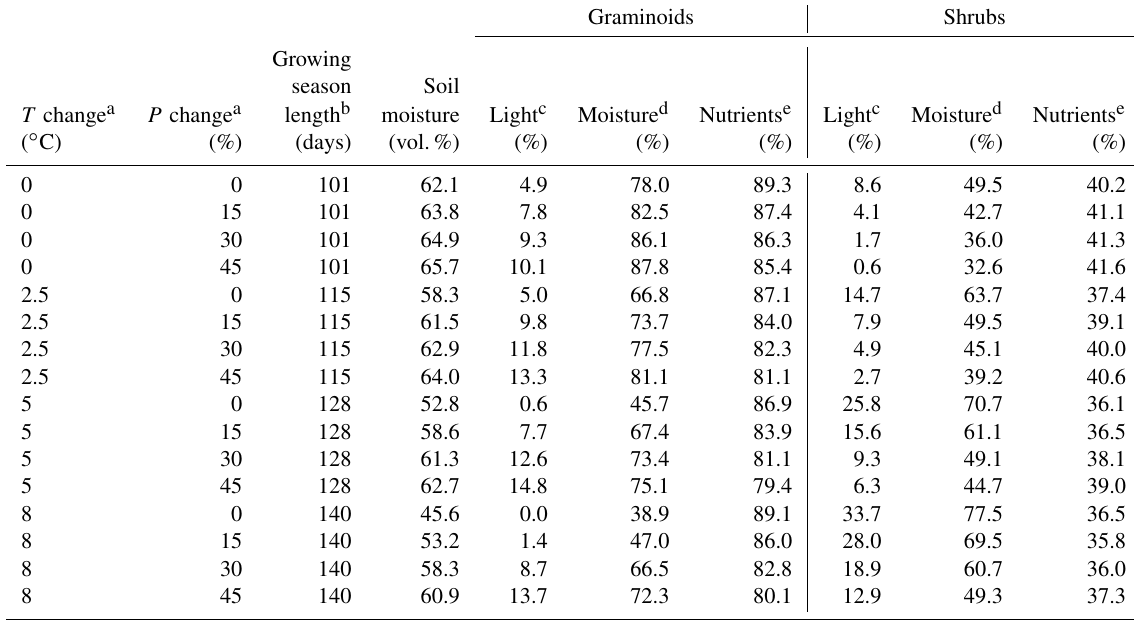
Table 1. Simulated growth-limiting factors for the vascular PFTs in vegetation type 3 under different climate change scenarios. Growing season length, soil moisture, and light, moisture and nutrient conditions during the growing season were averaged for years 2064–1974. Graminoids Shrubs